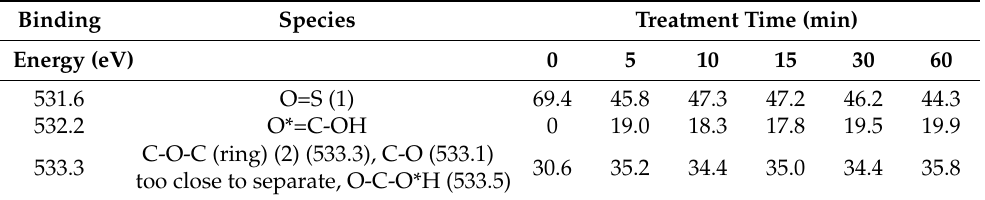
Curve-fitting the S 2p spectra (Figure 6) gave the correct ratio of 2:1 for 2p 3/2 and 2p 1/2 species separated by 1.2 eV (Table 3) for untreated PES [15]. With treatment time, there is an increase in the formation of sulphonate (-SO 3 ) and sulphate (-SO 4 ) moieties (Table